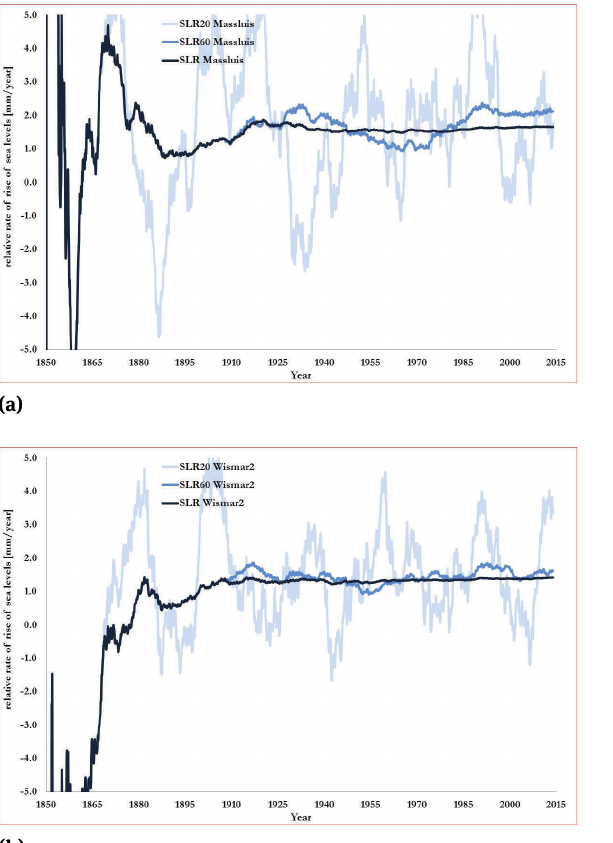
Fig. 5: Classical determination of the relative rate of rise by linear fitting in two tide gauges of North Europe, Massluis and Wismar2, with different subsidence but about same multi-decadal oscillation and length. In both tide gauges, the rate of rise is about constant over the full century. The short term tide window is misleading in both locations, showing relative rates of rise much larger or smaller than the true values. Massluis and Wismar2 are two of the only five tide gauges of the world in the PSMSL data base that may be used to study the sea level acceleration over the last 100 years.